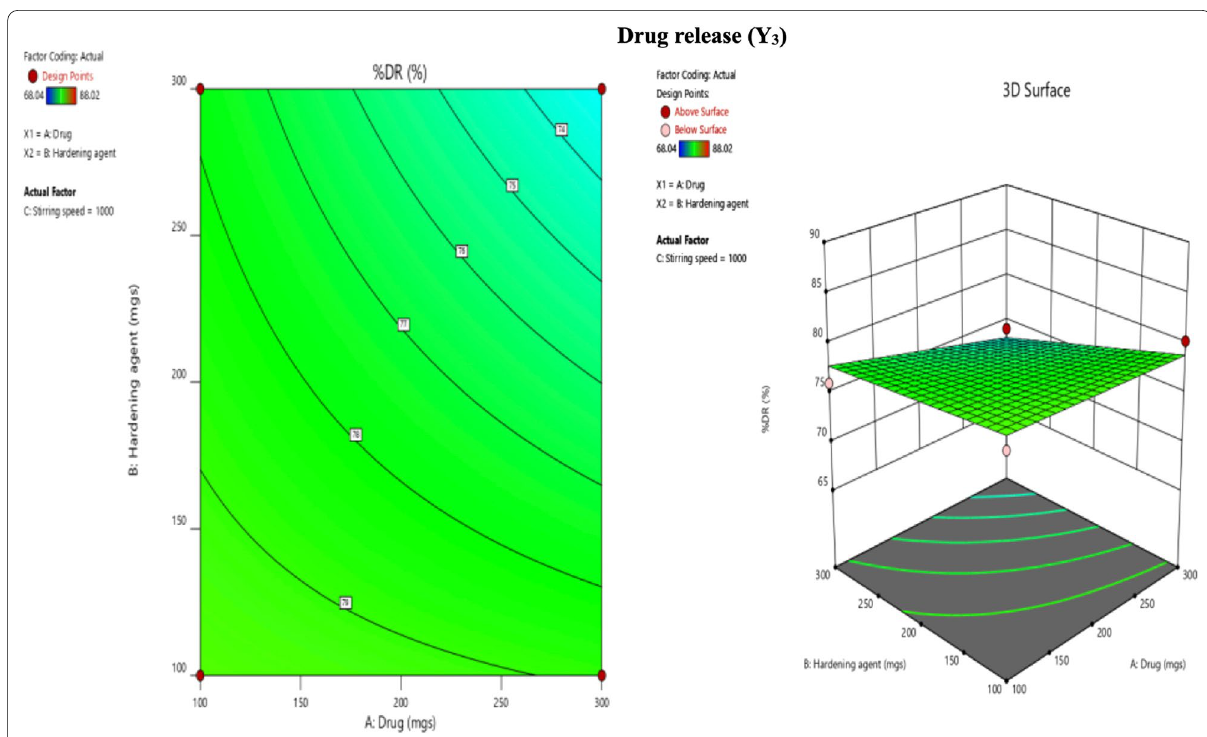
Fig. 3 Contour plot and 3D response surface plot for drug release ( Y 3